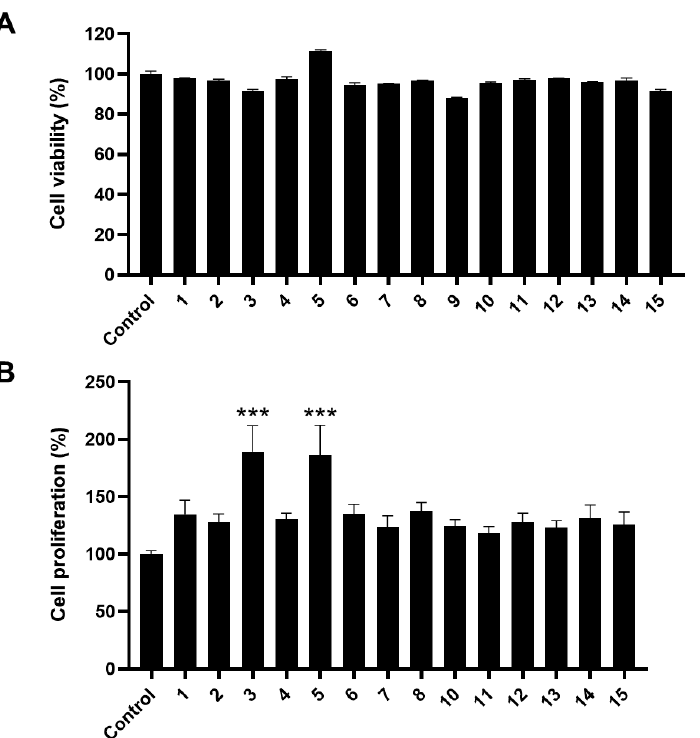
Figure 2. Cell proliferative effect of components from C. bignonioides fruits on mouse myoblasts. ( A ) Cytotoxicity measured by MTT colorimetric assay for 50 μ M concentration of compound 1 – 15 iso- lated from C. bignonioides on C2C12 cells. ( B ) Cell proliferation activity measured by BrdU assay of compound 1 – 8 and 10 – 15 at 50 μ M concentration on C2C12 cells during the differentiation period. Data are reported as mean ± SEM, obtained from at least triplicate determinations. *** indicates p < 0.001 calculated by one-way ANOVA.